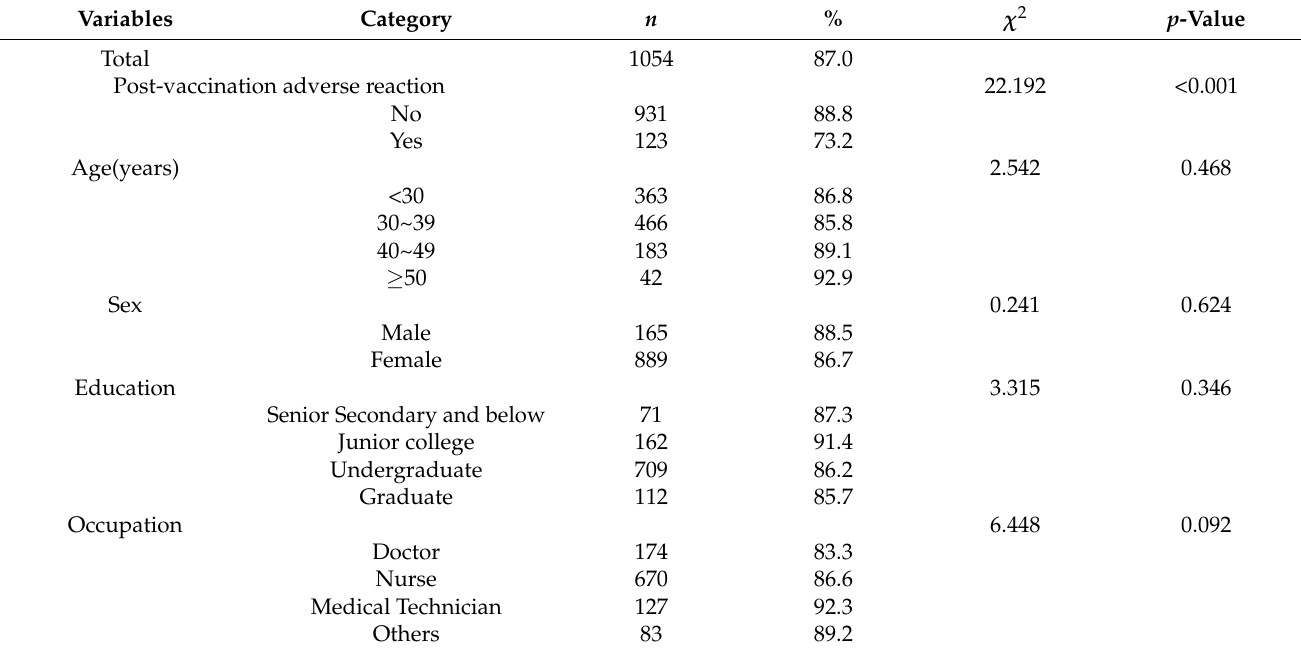
Table 2. Univariate analysis of factors associated with willingness to take the booster dose of COVID-19